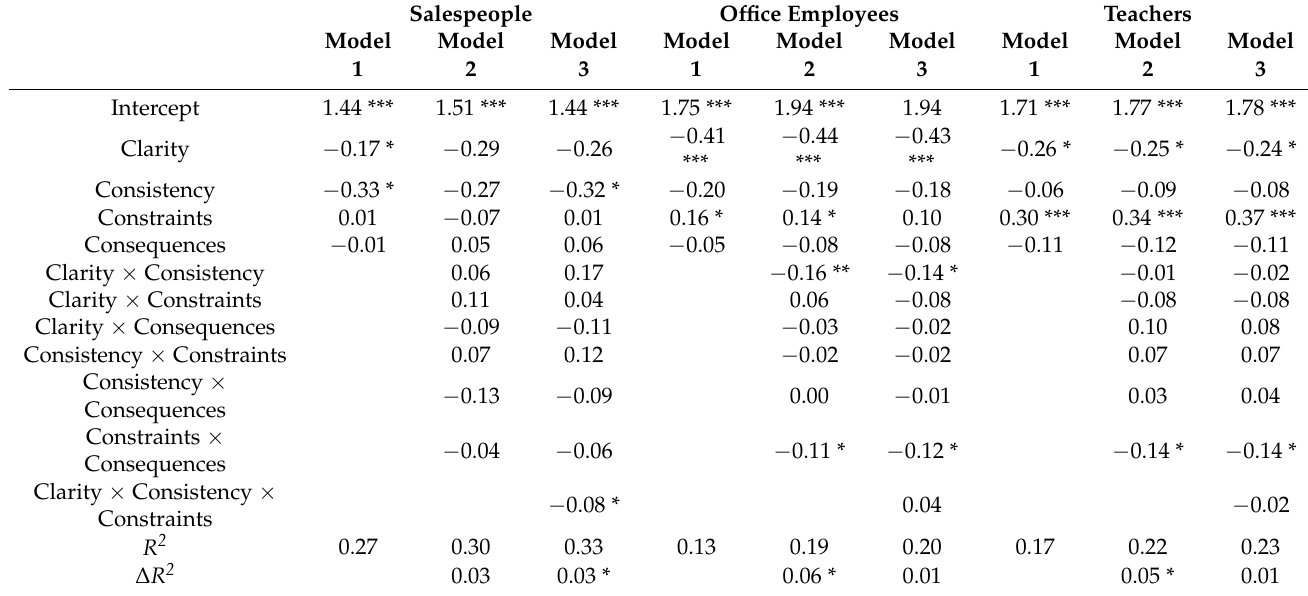
Table 4. Regression results of situational strength characteristics to explain